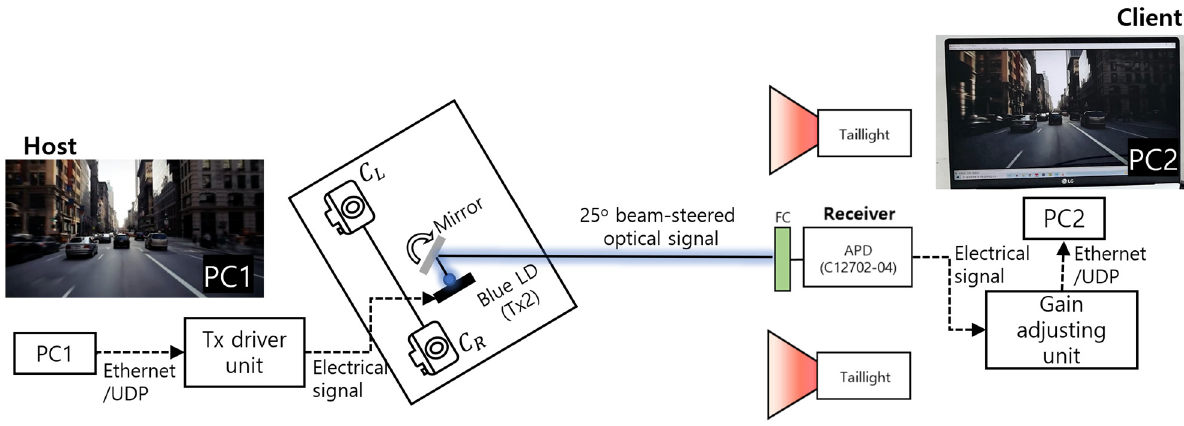
Figure 10. Real-time video-streaming demonstration.